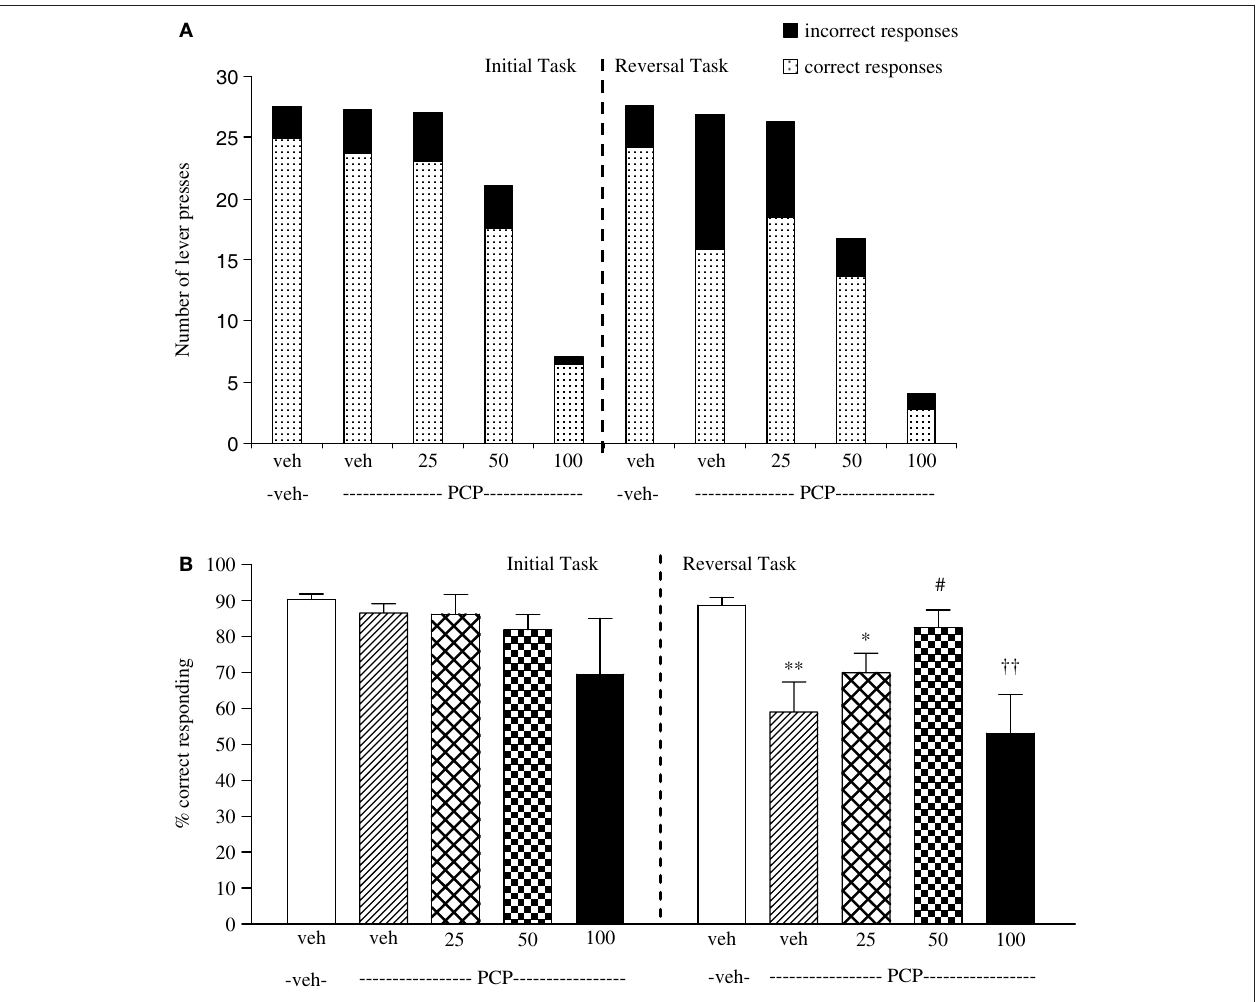
task. Data are shown mean ± S.E.M. percentage correct responding ( n = 8 per group). Signifi cant reduction in performance of the reversal phase compared with the initial phase; * P < 0.05, ** P < 0.01. Signifi cant reduction in performance of the reversal phase compared with the vehicle,